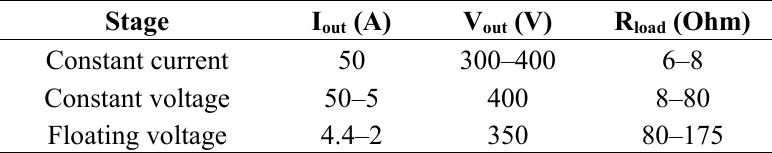
Figure 12. Three-stage charging process. Table 1. Three-stage charging